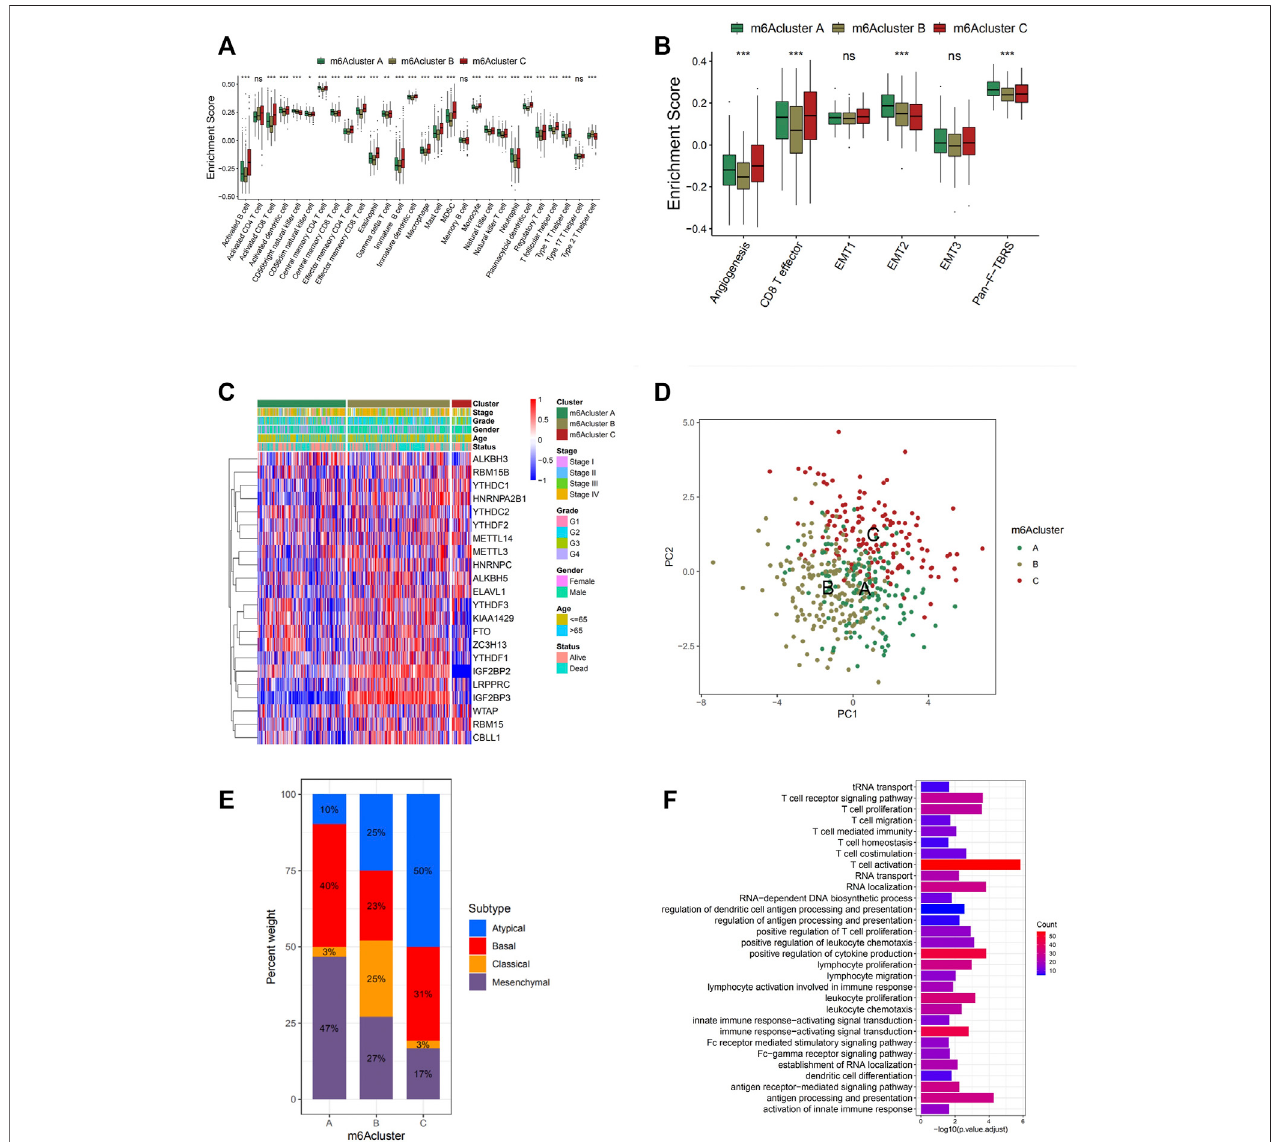
FIGURE3| Tumormicroenvironment(TME)cellin fi ltrationcharacteristicsandtranscriptometraitsindistinctm6Amodi fi cationpatterns. (A) Theabundanceofeach TMEin fi ltratingcellinthreem6Amodi fi cationpatterns.Theupperandlowerendsoftheboxesrepresenttheinterquartilerangeofvalues.Thelinesintheboxesrepresent median value, and black dots show outliers. The asterisks represent the statistical p -value (* p < 0.05; ** p < 0.01; *** p < 0.001). (B) Differences in stroma-activated pathways including epithelial-to-mesenchymal transition (EMT), TGF beta, and angiogenesis pathways among three distinct m6A modi fi cation patterns. The statistical differences among the three modi fi cation patterns were tested by the one-way ANOVA test. The asterisks represent the statistical p -value (* p < 0.05; ** p < 0.01; *** p < 0.001). (C) Unsupervised clustering of 21 m6A regulators in the GSE65858 cohort. The m6A cluster, molecular subtypes, tumor stage, survival status, and age were used as patient annotations. Red represents high expression of regulators, and blue represents low expression. (D) Principal component analysis for the transcriptome pro fi les ofthree m6A modi fi cation patterns, showing a remarkable difference in transcriptome between different modi fi cation patterns. (E) The proportion of four molecular subtypes of head and neck cancer in the three modi fi cation patterns. Atypical subtype, blue; basal subtype, red; classical subtype, orange; mesenchymal subtype, purple. (F) Functional annotation for m6A-related genes using Gene Ontology (GO) enrichment analysis. The color depth of the barplots represents the number of genes